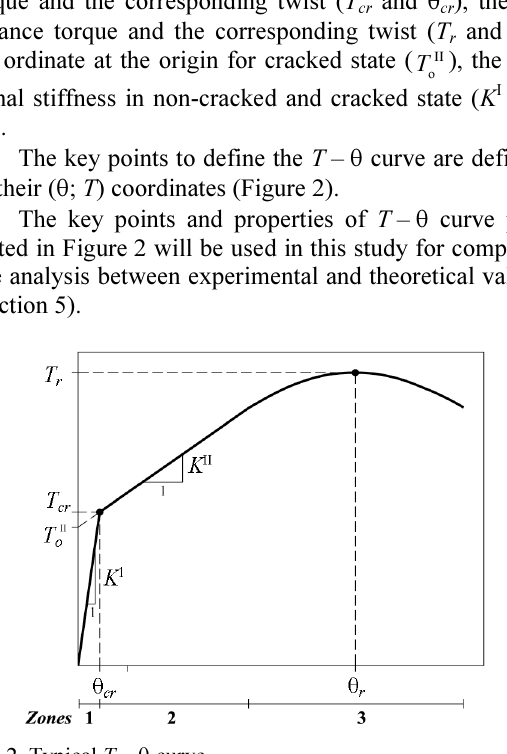
Fig. 2. Typical T – θ